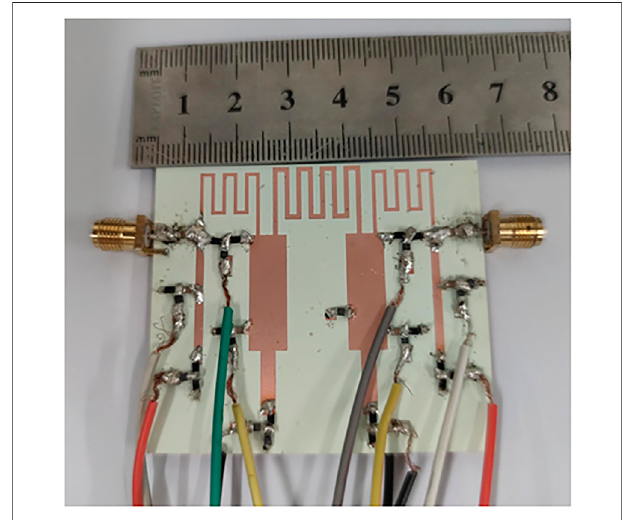
FIGURE 6 | The fabricated TLPF. The measured performance is shown in Figure 7 .